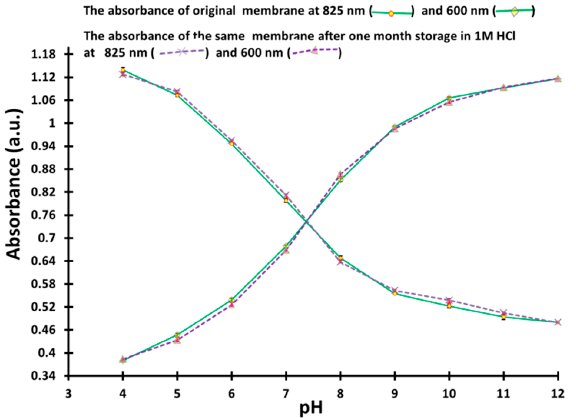
Figure 7. Performance of PANI-PSU-20 membranes after 1 month storage in 1 M HCl. Error bars indicate the standard deviation of absorbance for three replicate samples.